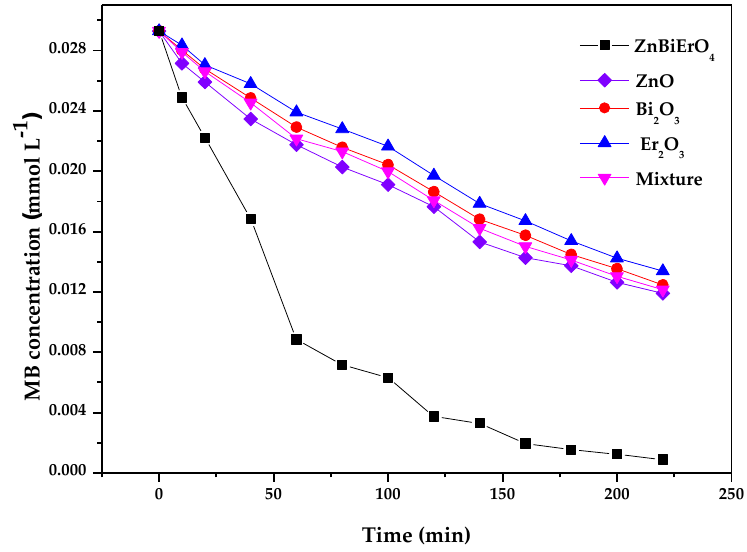
Figure 17. Photocatalytic degradation of methyl blue under visible light irradiation in the presence of ZnBiErO 4 , ZnO, Bi 2 O 3 , Er 2 O 3 and mixture.